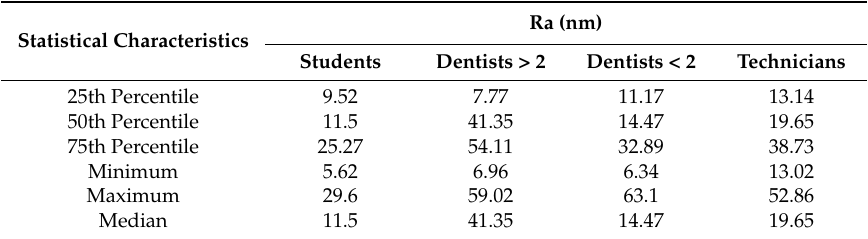
Table 3. Descriptive analysis of the Ra values (nm) of investigator 1 and trial two achieved by the specific practitioner groups